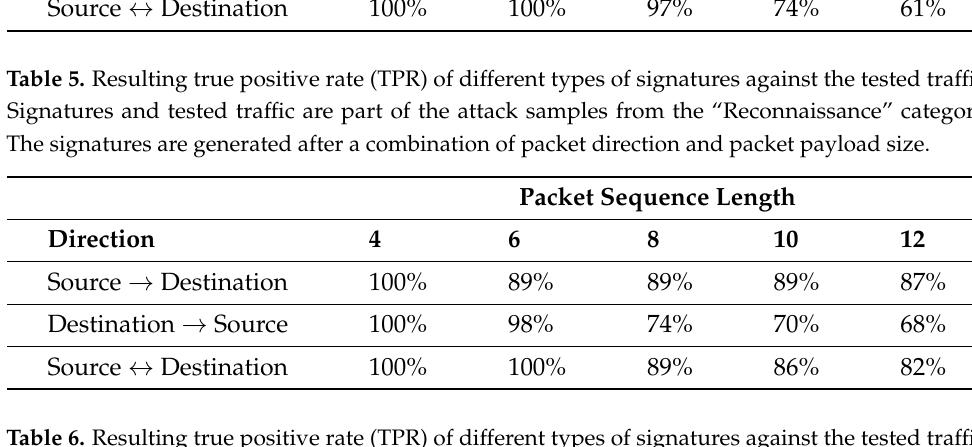
Table 6. Resulting true positive rate (TPR) of different types of signatures against the tested traffic. Signatures and tested traffic are part of the attack samples from the “DoS” category. The signatures are generated after a combination of packet direction and packet payload